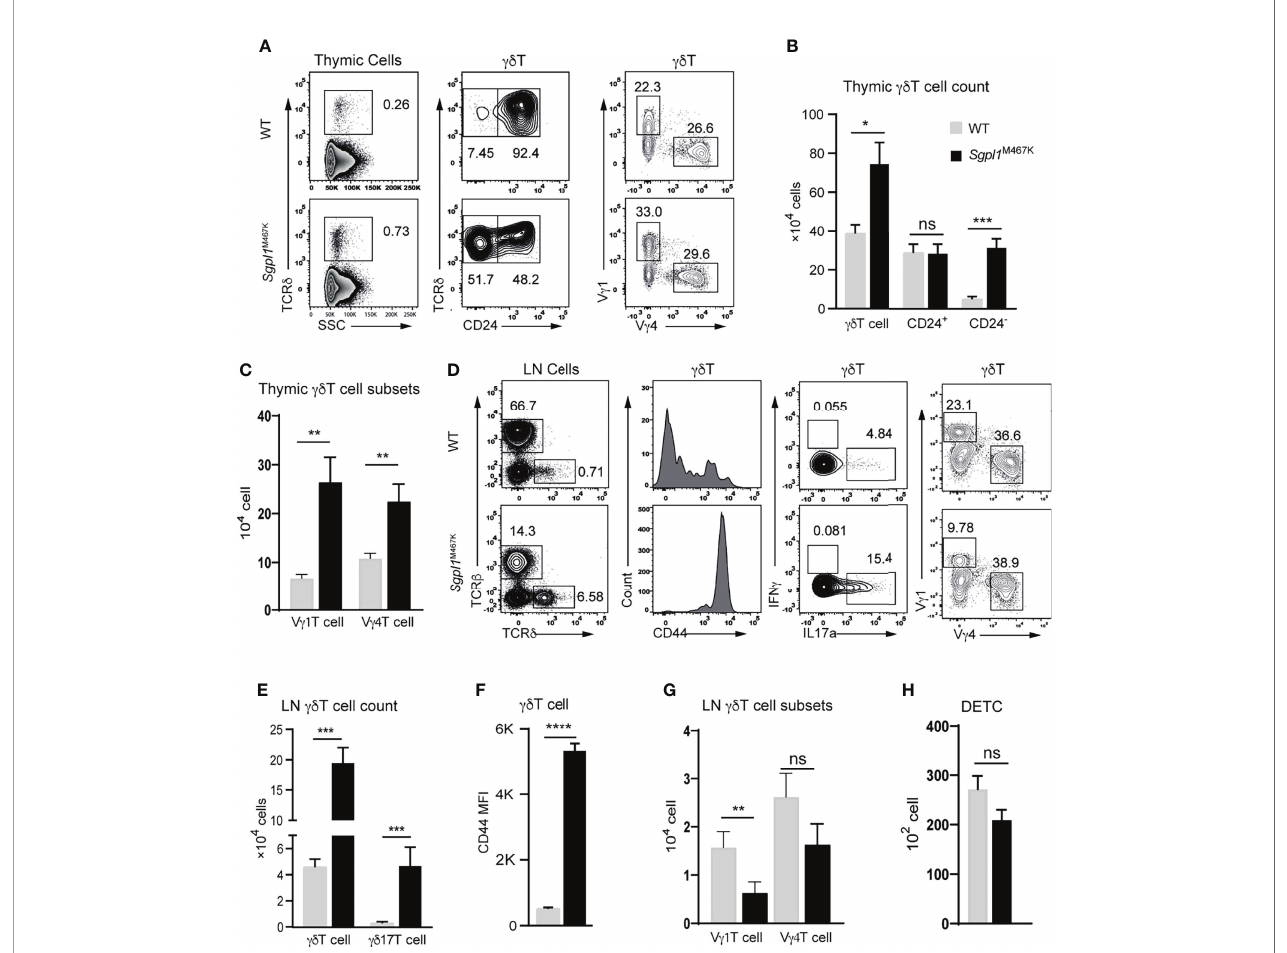
FIGURE 6 | Sgpl1 M467K mutation partially impairs gd T cell migration. (A – C) Thymic gd T cell count was accessed with fl ow cytometer. (A) Representative fl ow cytometer fi gure; left, gd T cells were grouped from total thymocytes; middle, the gd T cell were subdivided into CD24 + and CD24 - populations, or V g 1 and V g 4 populations on the right. (B, C) Absolute cell count of thymic gd T cell population; data pooled from three experiments (B) ; data pooled from three experiments, which analyzed seven wild-type and fi ve mutant mice. (D – G) gd T cells counts within mesenteric LN (mLN) were accessed with a fl ow cytometer. (D) Representative fl ow cytometer fi gure; left, gd T cells were grouped from total mLN cells; the CD44 expression, or IL17a + , IFN g + , V g 4 + , V g 1 + populations were analyzed. (E) gd T and gd 17T cell count. (F) gd T cell CD44 mean fl uorescent density (MFI). (G) V g 4 + or V g 1 + cell count within mLN. Data were from two experiments, three-four mice were used for each experiment. (H) DETC count from two ears; gating strategy refers to Figure 3B . Data pooled from thirteen wild-type and eleven mutant mice. ****, p<0.0001; ***, p<0.001; **, p<0.01; *, p<0.05; ns, not signi fi cant; unpaired